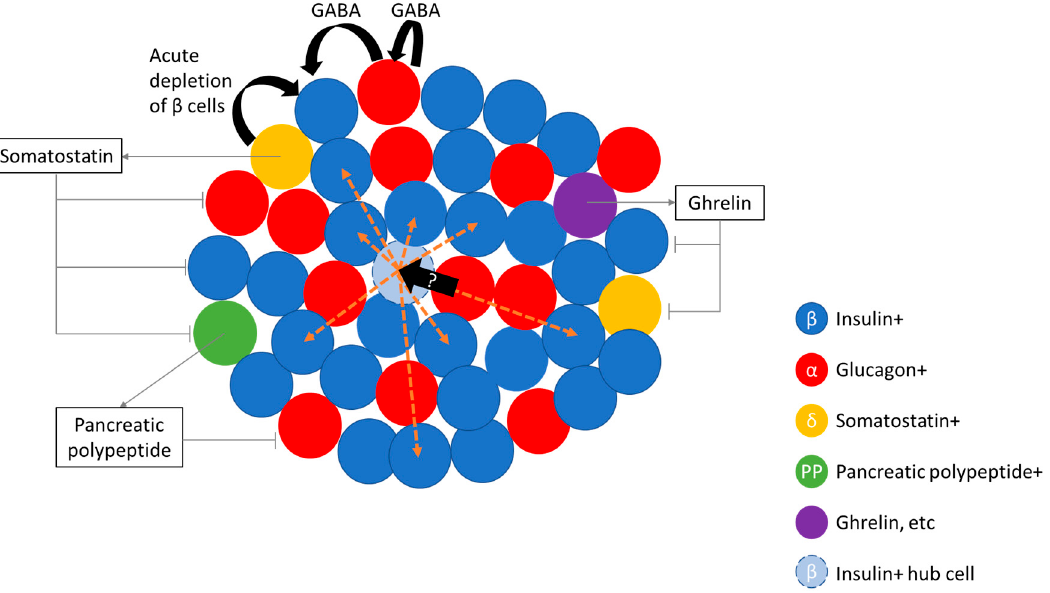
Figure 1. Schematic diagram showing the interdependency of islet cells. Evidence in the literature points to the possibility of the transdifferentiation (solid black arrows) of α -cells (red circle) via stimulation by gamma aminobutyric acid (GABA), and δ -cells (yellow circle) into insulin-containing β (like)-cells (blue circle). It is currently unclear whether the replenishment of β -cells from the transdifferentiation of α -cells is able to replace hub β -cells (light blue circle) which influence (yellow arrows) the function of other β -cells. Somatostatin, released from δ -cells, can inhibit the release of glucagon, insulin, and pancreatic polypeptide from α -, β -, and PP cells (green circle), respectively. Pancreatic polypeptide, released from PP cells, can inhibit the release of glucagon. Ghrelin, released from ghrelin-positive islet cells (purple circle), can inhibit insulin and somatostatin secretion.